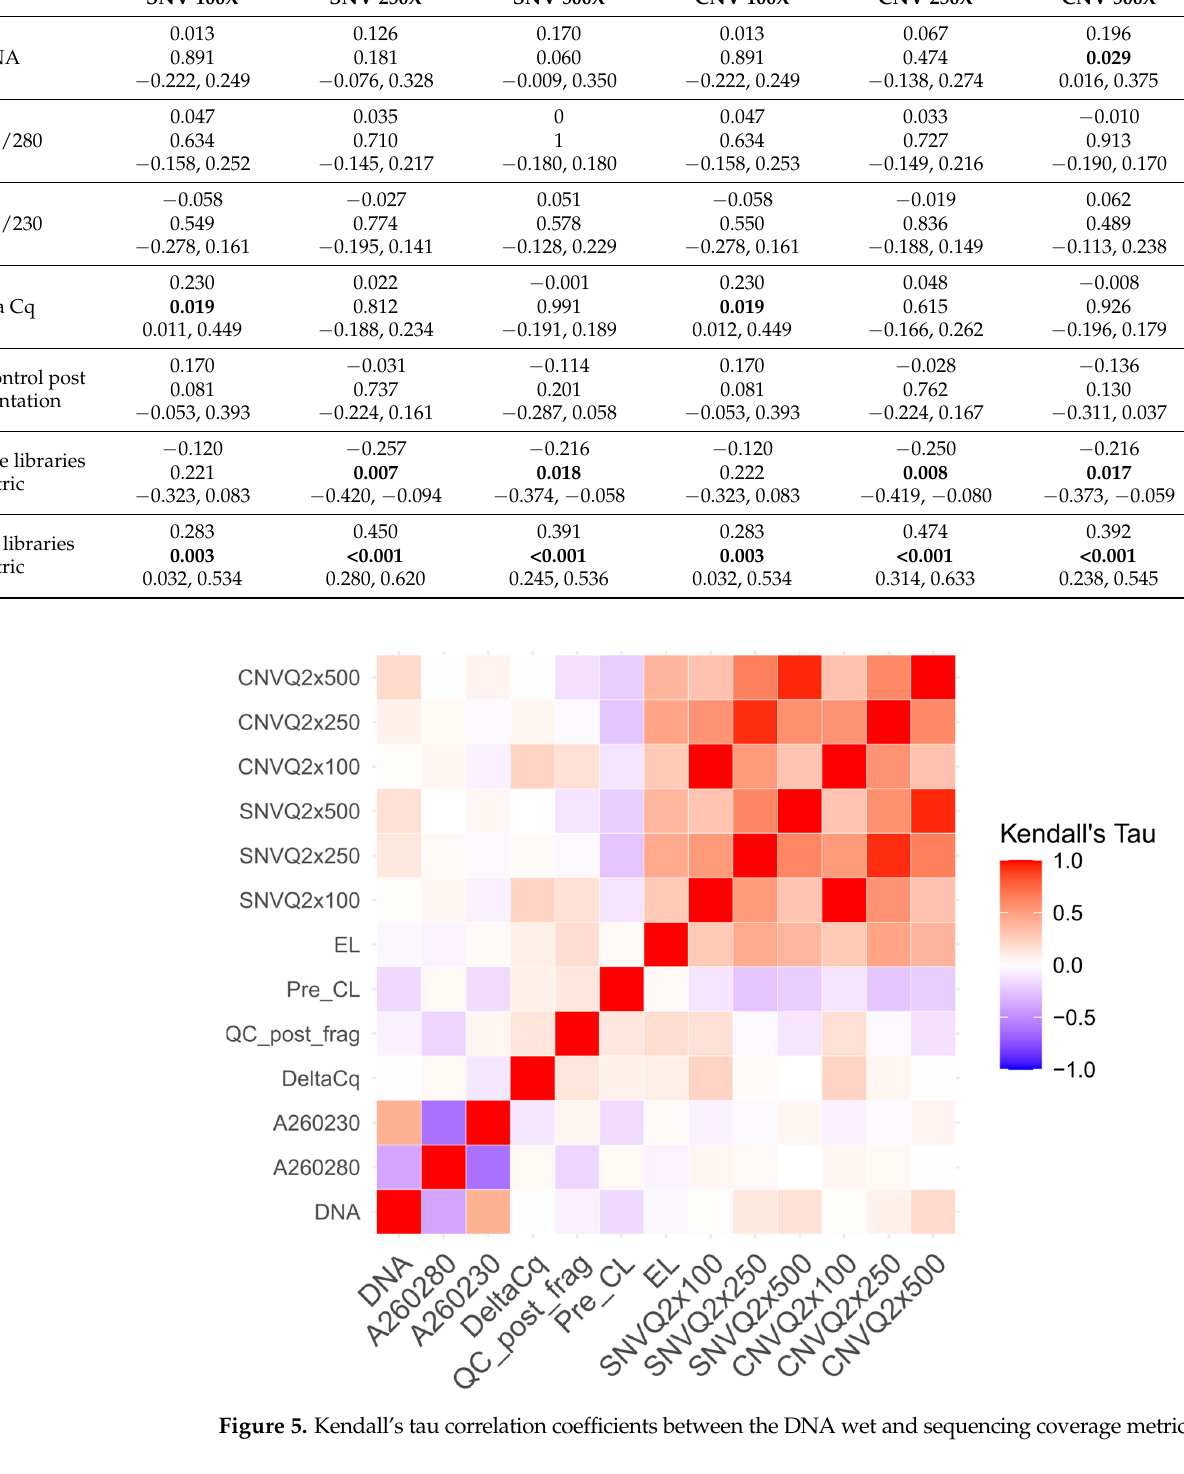
Table 3. Correlation analysis between the median coverage and wet metrics for the DNA samples. Correlations were evaluated through a tau test, evaluating the Kendal’s rank correlation (tau) significance between wet metrics and coverage at three different depths (100X, 250X and 500X) for SNV and CNV. Each cell reports: Kendall’s tau coefficient, p -value and tau 95% confidence interval. Significant correlations ( p -value < 0.05) are highlighted in bold. SNV 100X SNV 250X SNV 500X CNV 100X CNV 250X CNV 500X